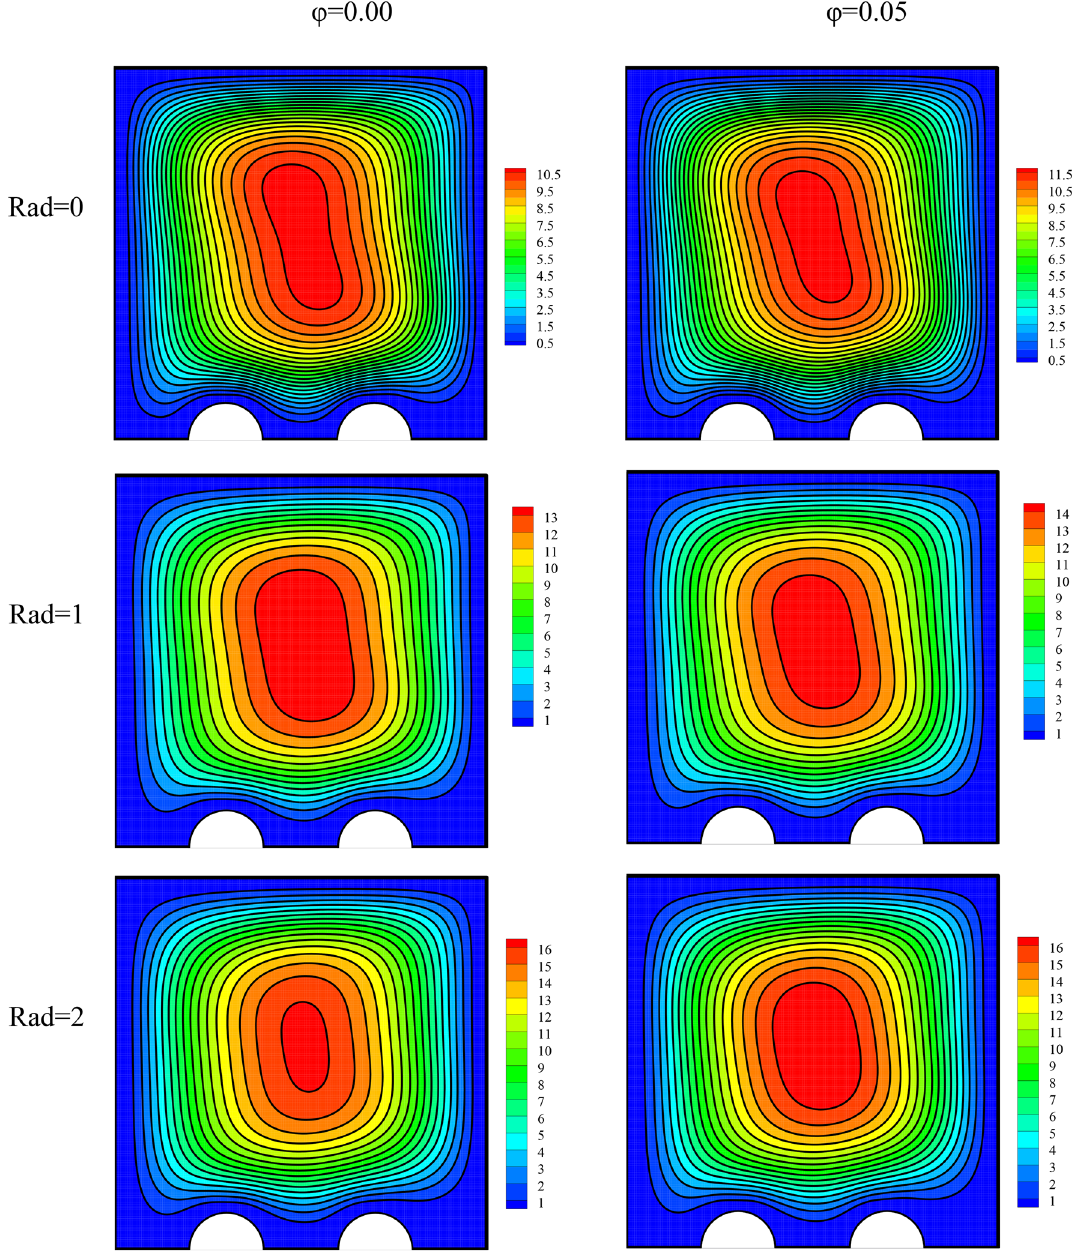
Figure 4. The flow field for a variable radiation parameter and different volume fractions at λ = 0°, Ra = 10 5 , γ = 45°, Ha =